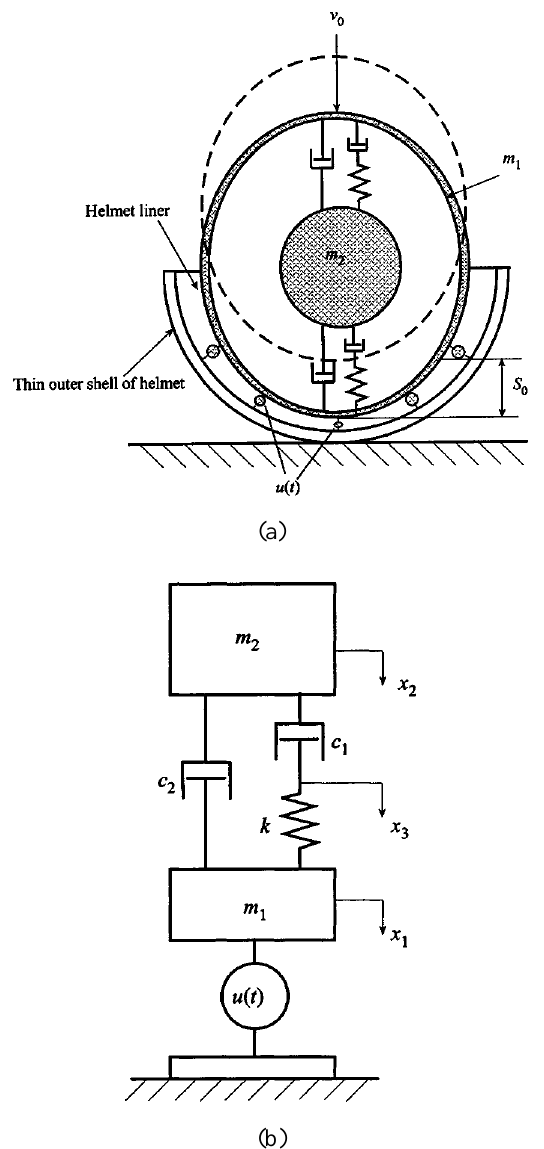
Fig. 3. Helmeted head impacting on a surface using THIM. (a) Illus- tration of the problem. The springs and dashpots model the dynam- ics of the skull and the damping of the brain. m 1 : mass of impacted skull bone; m 2 : mass of brain and the rest of skull bones; S 0 : rat- tlespace of helmet, permissiable displacement of the head; u ( t ): con- trol force. (b) Physical model for the limiting performance